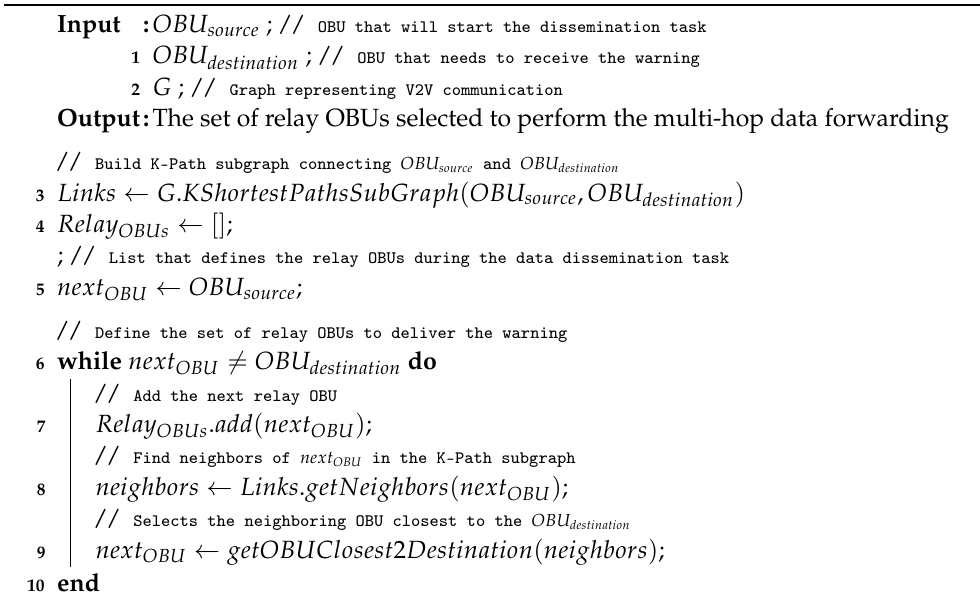
Algorithm 2: Data dissemination algorithm based on the trajectory and density